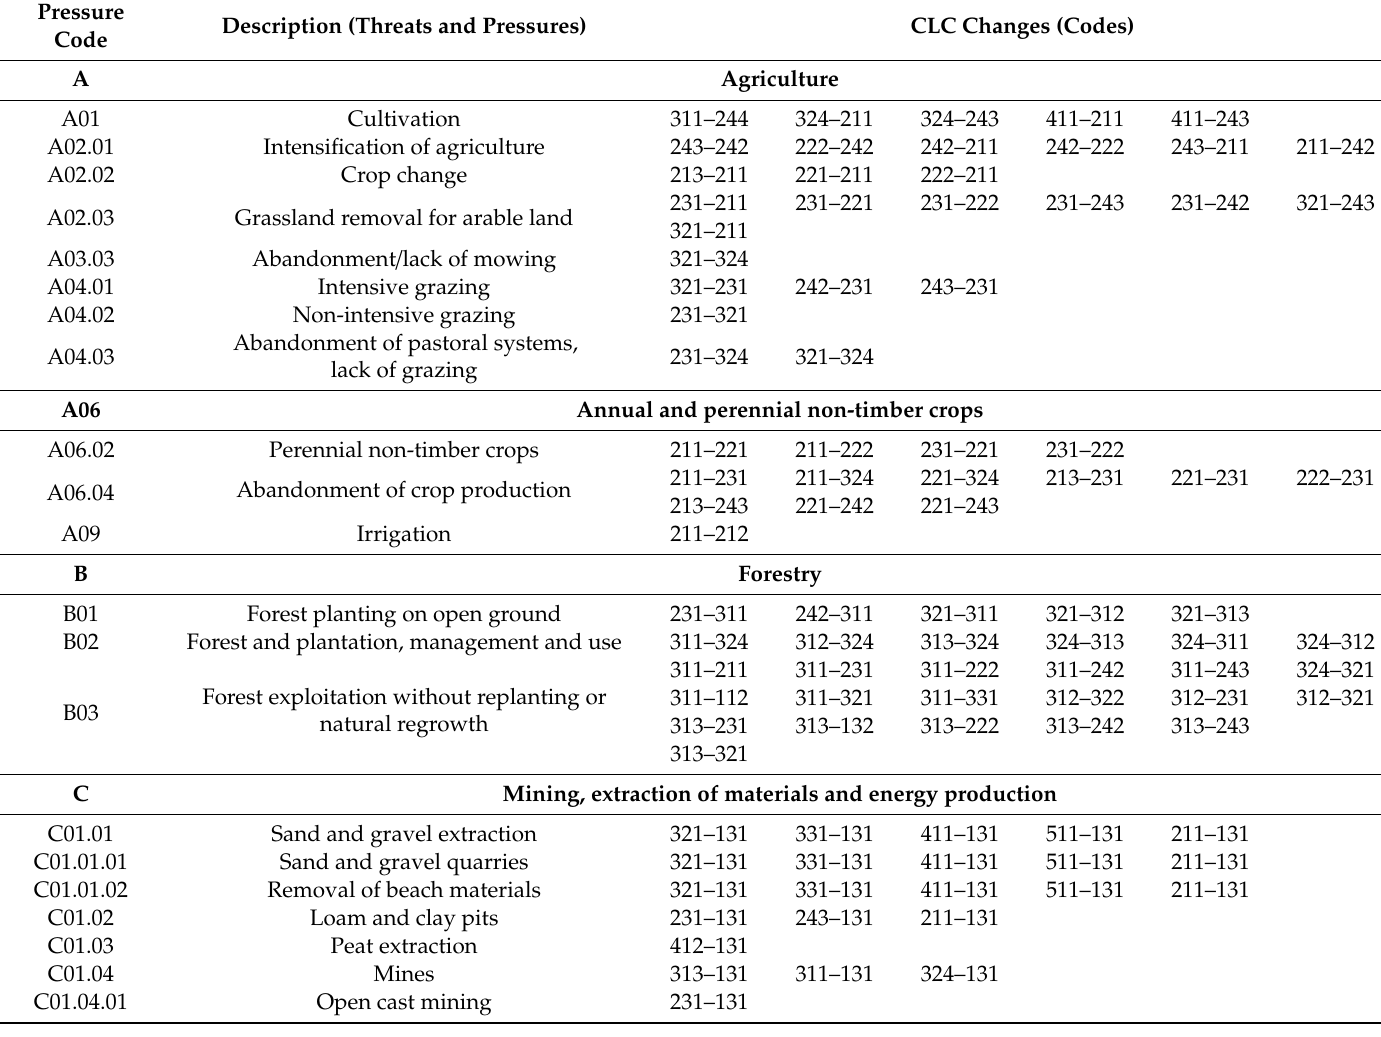
Table 3. Pressures and Threats Associated with Types of